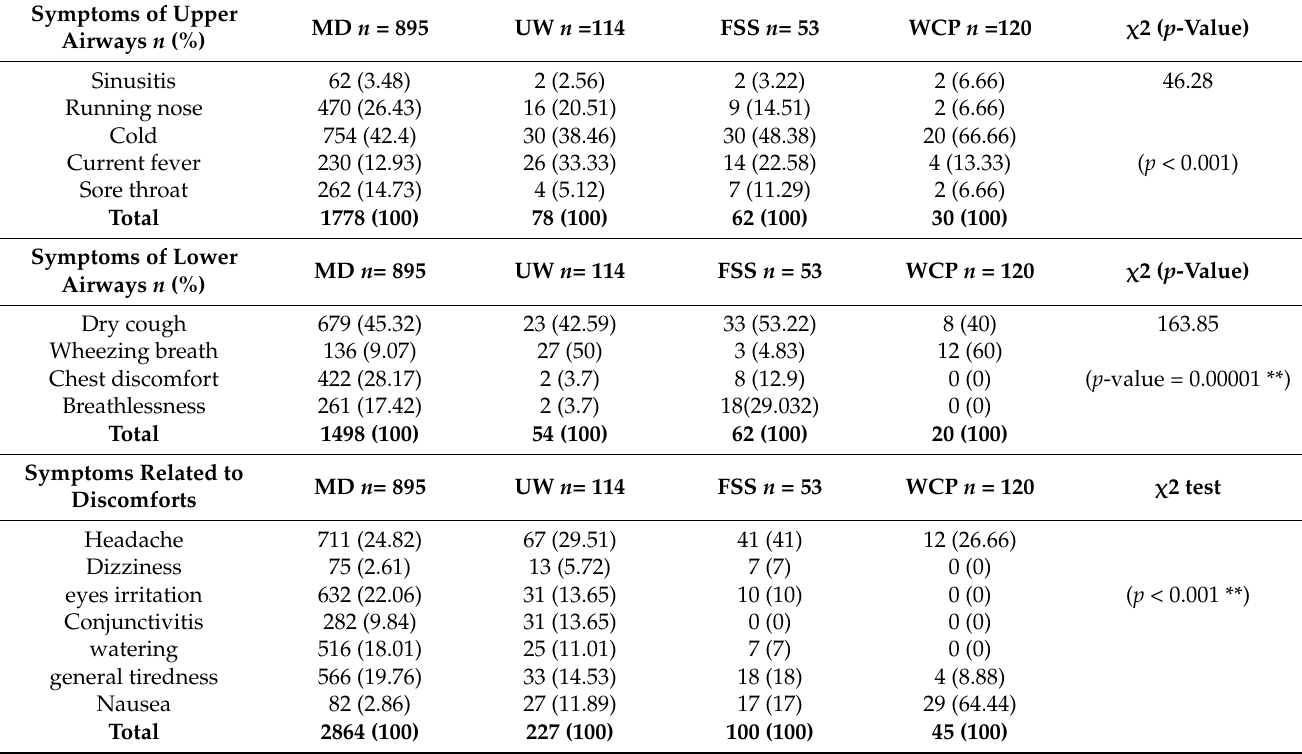
Table 3. Distribution of symptoms and diseases ( n and %) in the studied